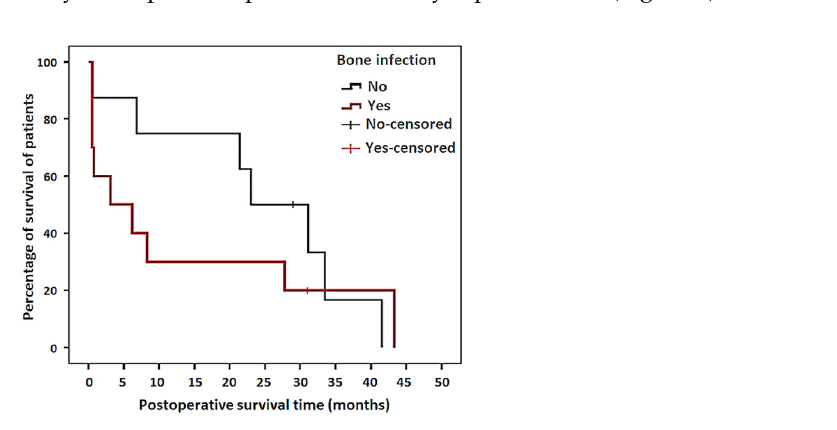
Figure 4. Kaplan–Meier survival curve comparing the cumulative postoperative survival of pa- tients of group 1 (septic bursitis only—No) with patients of group 2 (concurrent bone infection—